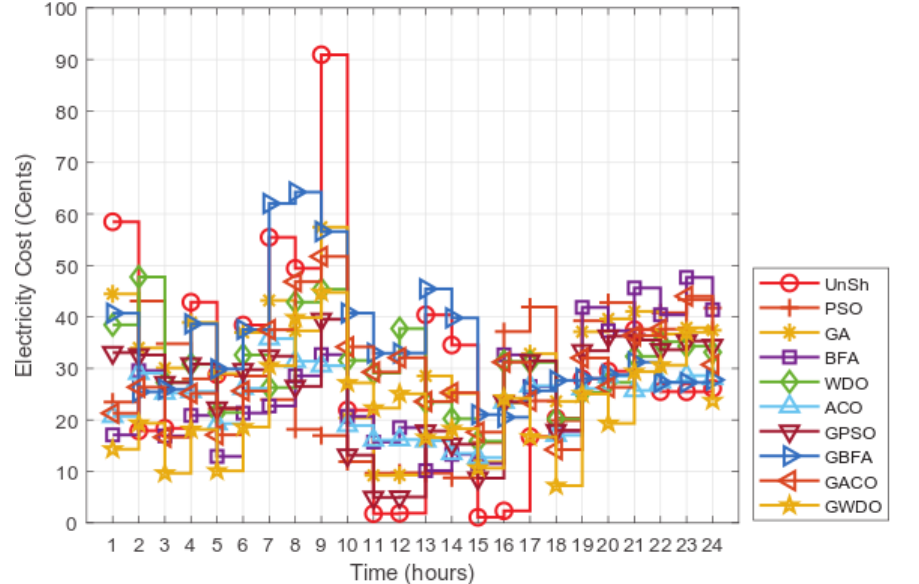
Figure 9. Case study 2: Electricity cost evaluation.